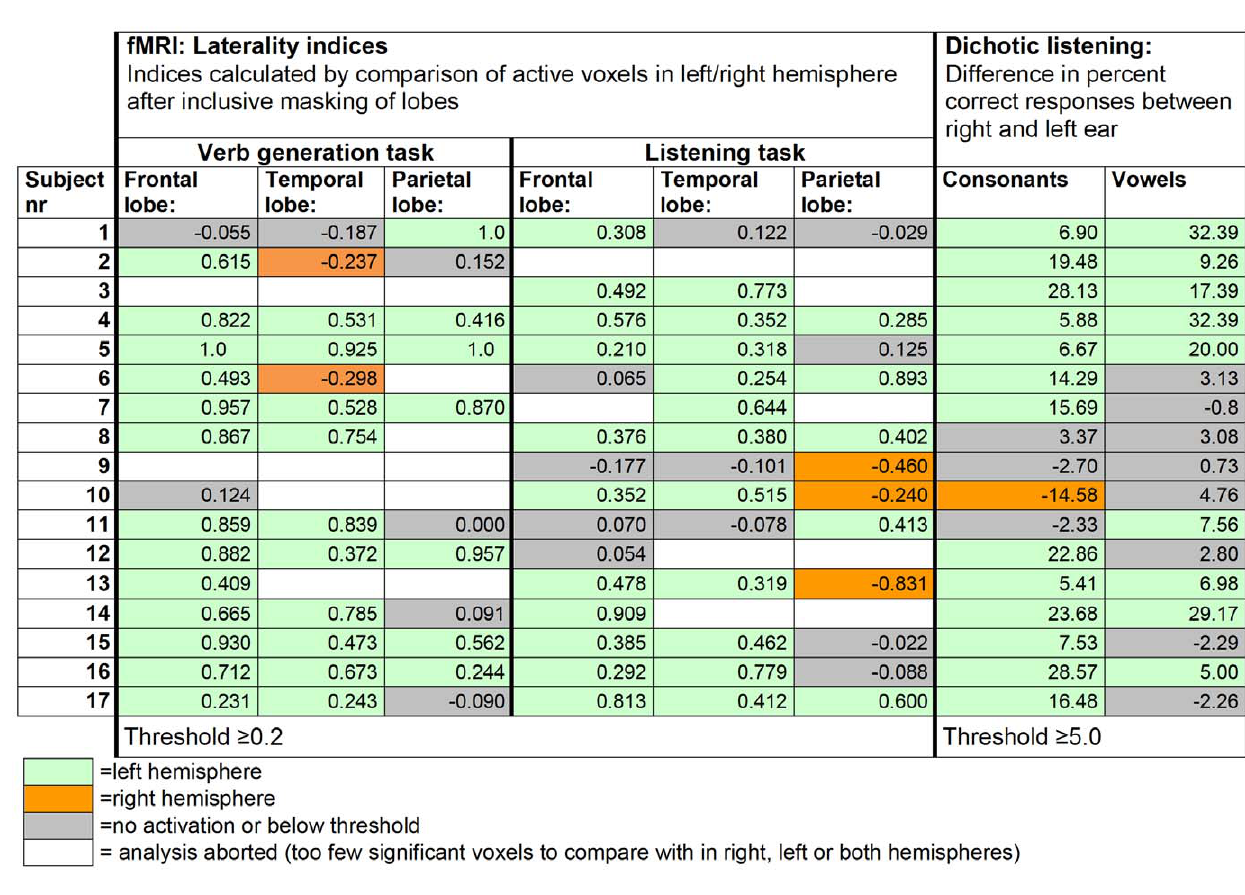
Figure 3. Results on the two language fMRI tasks and on dichotic listening for each subject. The fMRI results on each task are based on significant BOLD signal changes in response to the task condition contrasted by the control condition.